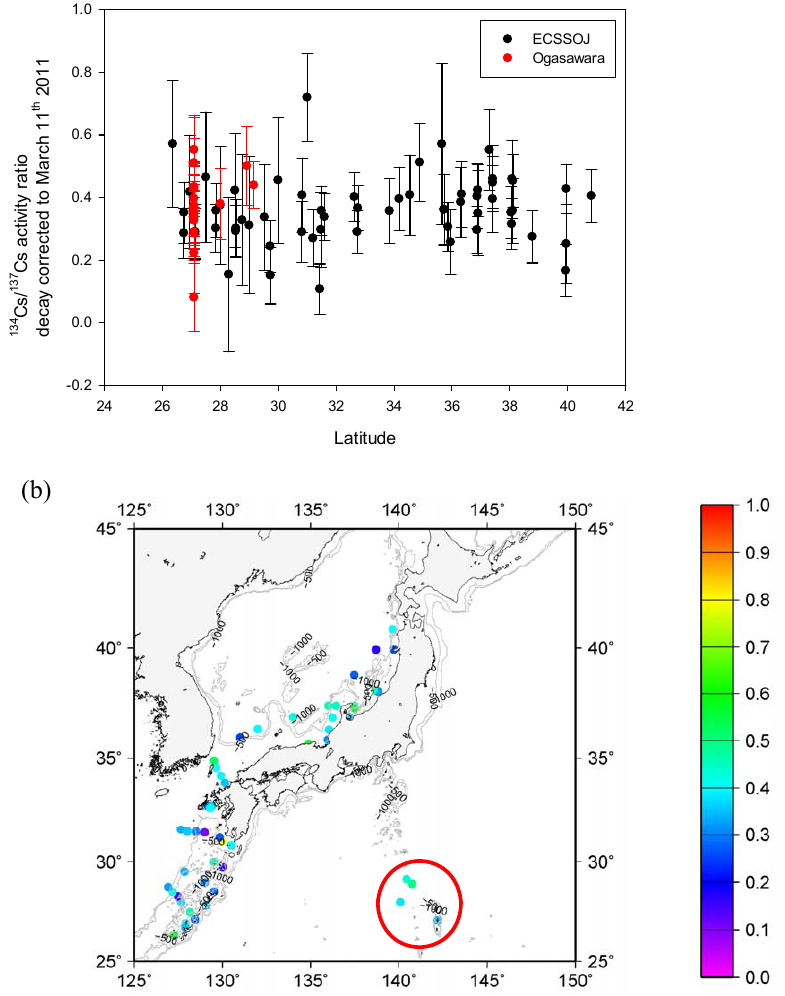
Figure 9. Latitudinal and horizontal distributions of the 134 Cs / 137 Cs activity ratios measured at the coastal sites of the SOJ and ECS in 2015–2016. The values were radioactive decay-corrected to 11 March 2011. The data measured in the Ogasawara area (red circle in b ) were also added. (a) Latitudinal distribution; (b) horizontal